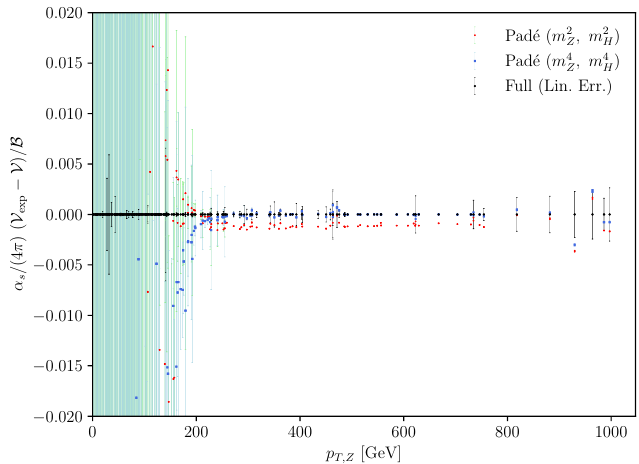
Figure 2. Comparison of the full and Padé improved high-energy expanded results normalised to the Born result, as a function of p quadratic terms, ( m 2